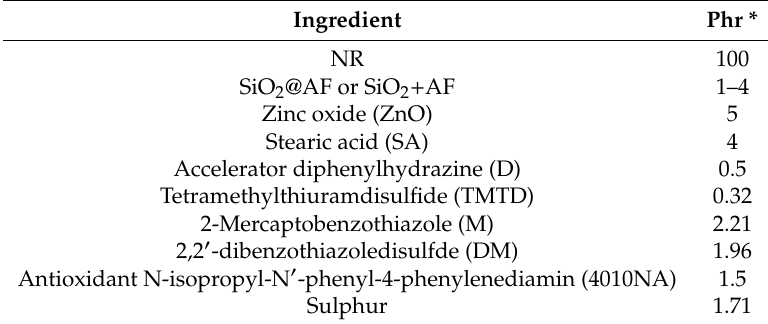
Table 1. Curing formula of the NR